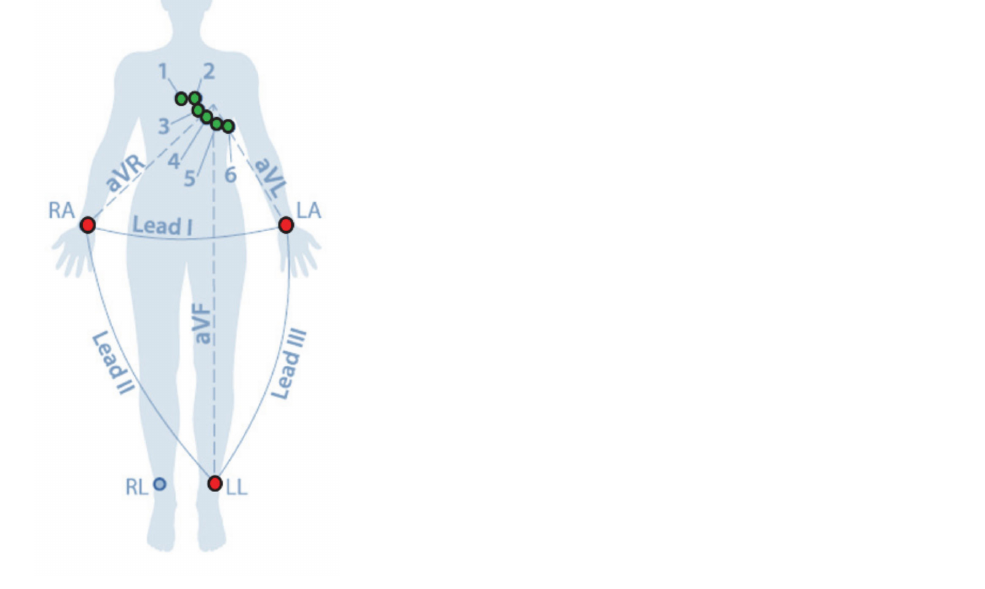
Figure 2. Medical acquisition settings: electrode placement and leads on the standard 12-lead configuration.